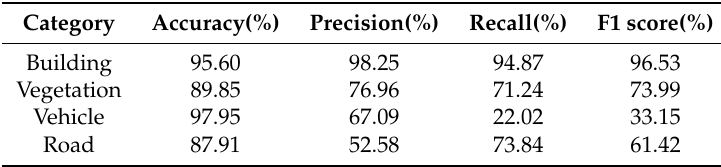
Figure 5. Visualization of PKU-M1.( a ): A sample image of PKU-M1, ( b ): ground truth of ( a ), ( c ): prediction of ( a ), and ( d ): 3D re-projection map of ( a ). Since the re-projection map ( d ) is quite sparse, we use Pixel Accuracy to compare the re-projection map and the ground truth map. Grey : Building, Green : Vegetation, Blue : Vehicle, Pink : Road, Black : Background. Best viewed in color. Table 1. Evaluation of 2D semantic